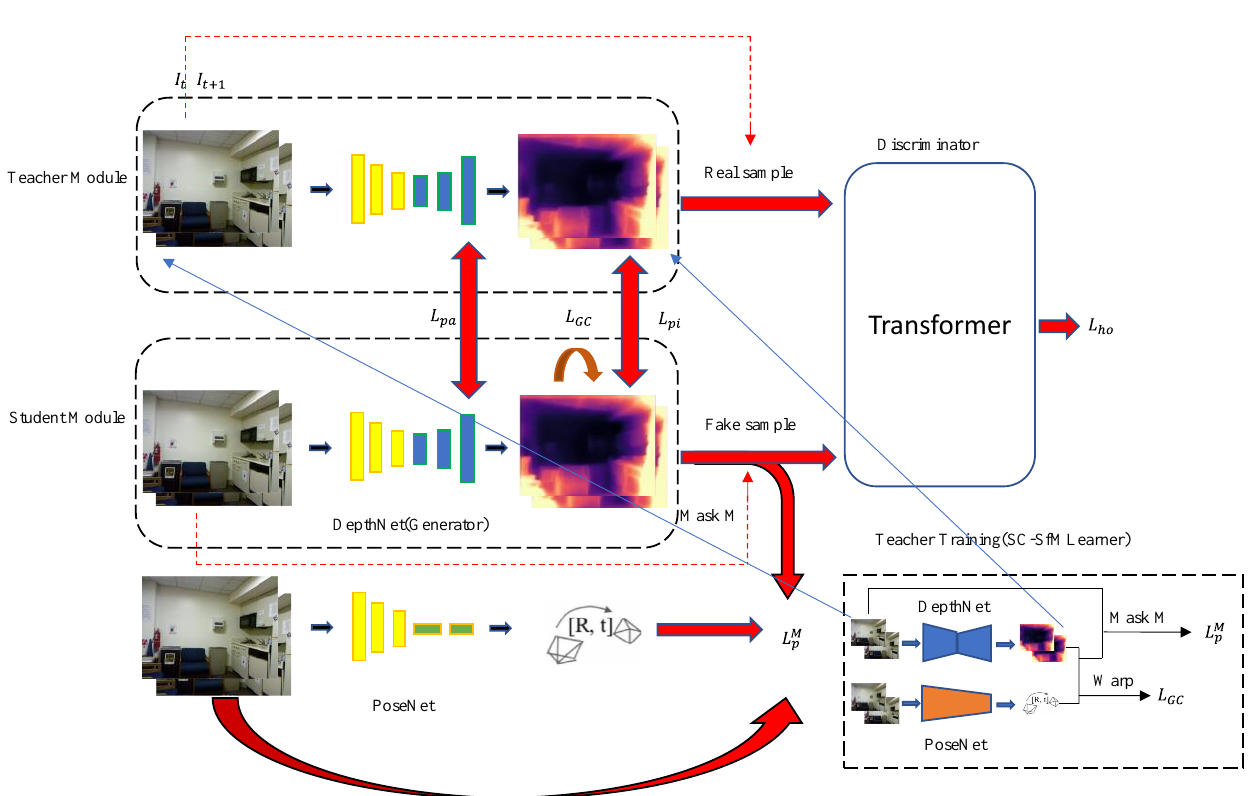
Figure 1. Overview of the LUMDE architecture. Baseline results are generated by the knowledge distillation module with pixel-wise loss, pair-wise loss, and holistic loss (CNN discriminator). PoseNet is further incorporated into the student network to improve model performance during training, and Transformer is adopted to replace CNN as the discriminator in the GAN.